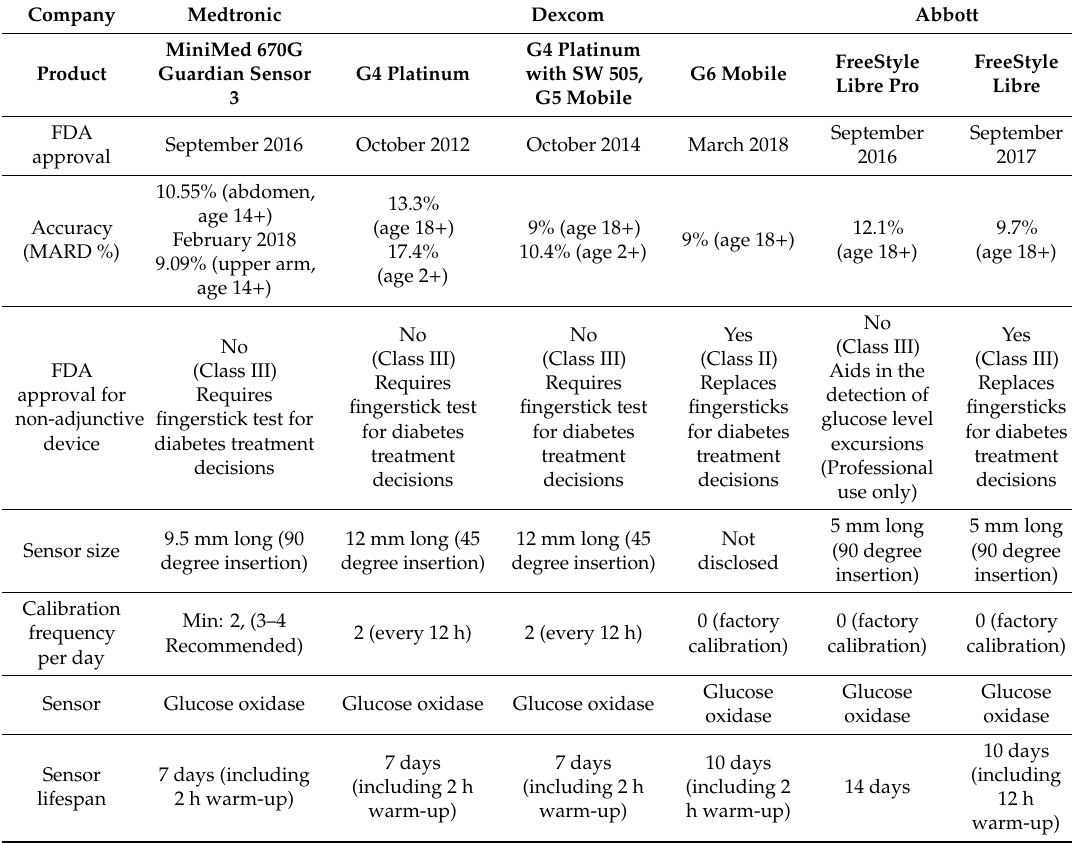
Table 2. Comparison of commercial “continuous glucose monitoring”